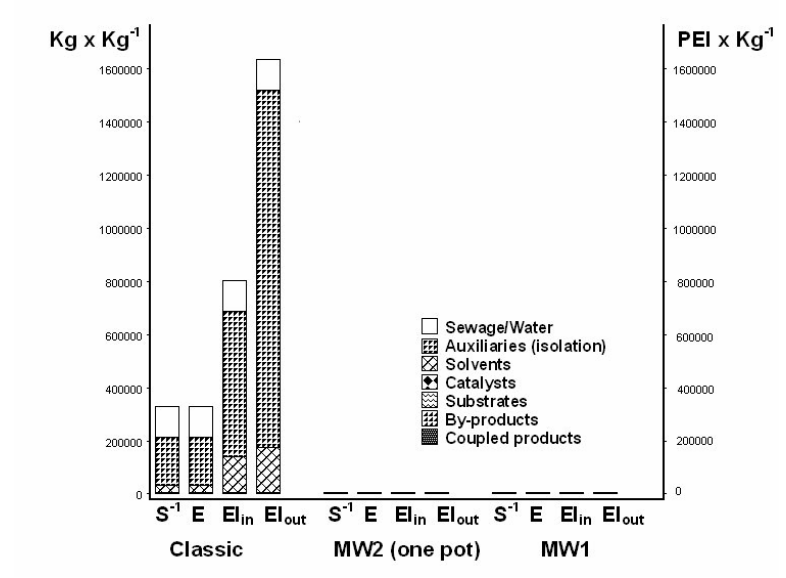
are reported. As the order of magnitude of the environmental impact of the classic procedure is much higher, the green metrics relative to MW1 and MW2 processes are also shown in detail in Figure 5. Figure 4. Evaluation histograms of classic versus MW-mediated solvent-free approaches, MW1 and MW2 (one pot), for the synthesis of compound a . S -1 = inverse selectivity (or mass index). E = environmental factor. EI and EI represent respectively S -1 and E in out weighted in function of the “weighting factors”: costs, risk, human toxicity, eco- toxicology. PEI represents Possible Environmental Impact.